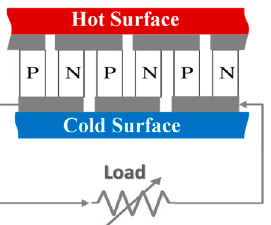
Figure 2. Schematic of a thermoelectric generator. Due to the Seebeck effect, the temperature difference ∆ T between the hot and cold sides of the TEG will generate an output voltage expressed by (5)